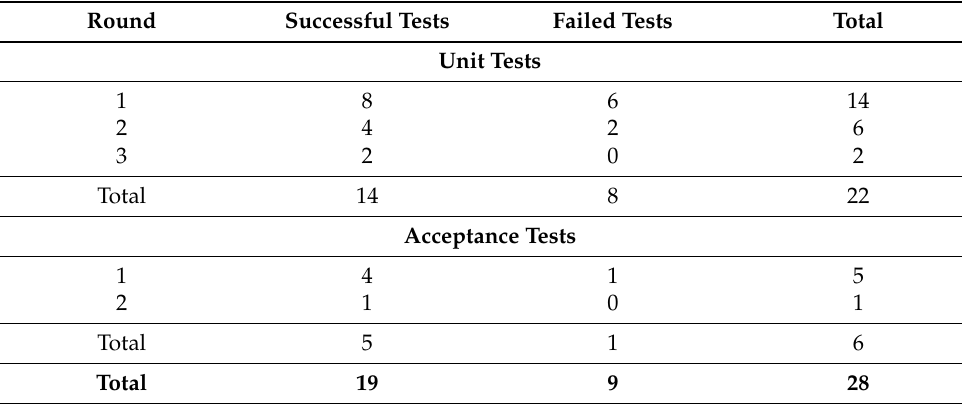
Table 3. Table of tests performed during the first iteration. Round Successful Tests Failed Tests Total Unit